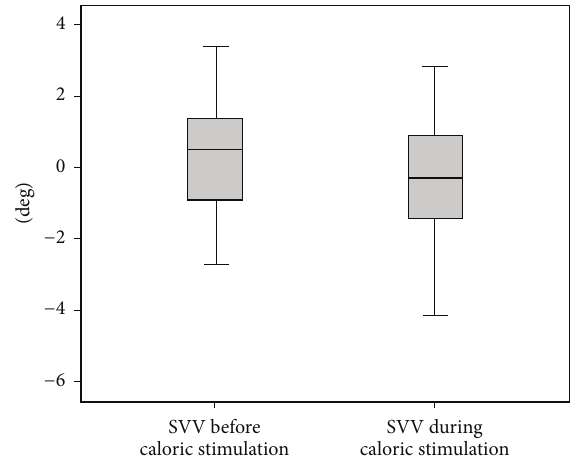
Figure 2: Box plot of subjective visual vertical (SVV) before and during caloric stimulation. Paired t -test: p =